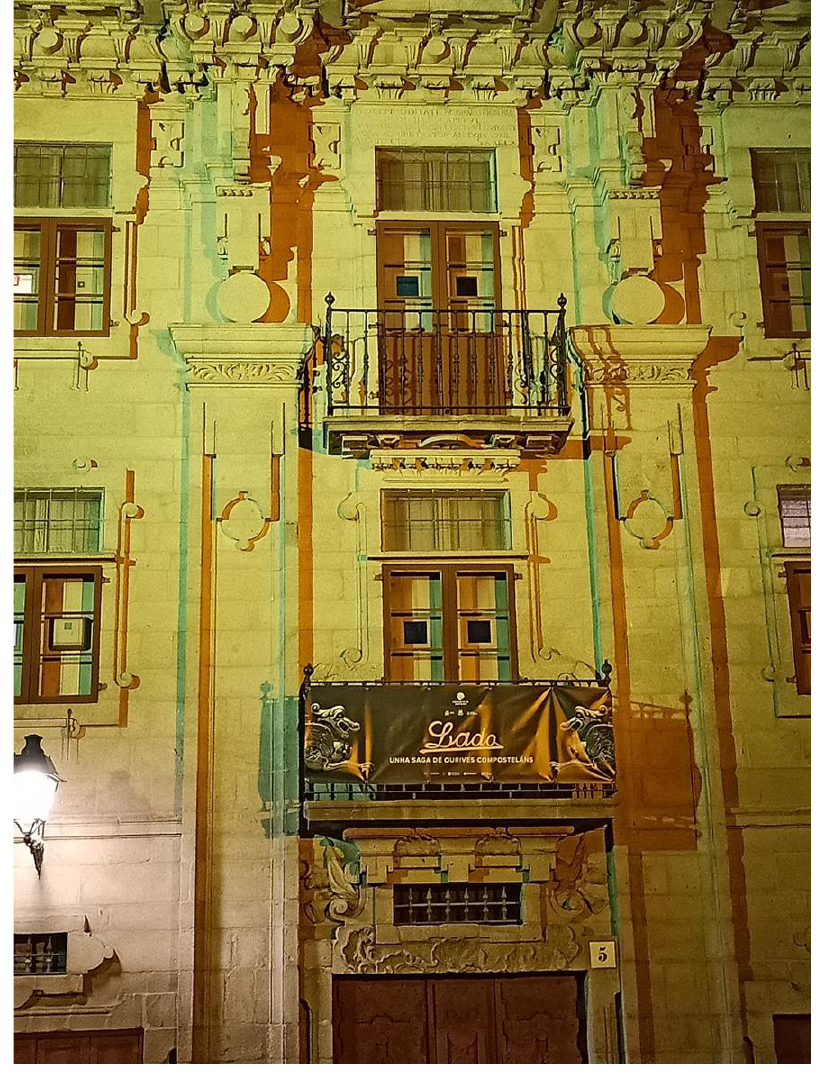
Figure 1. The baroque facade of the Casa do Cabildo house, built in 1758, illuminated by the CromaLux lighting.